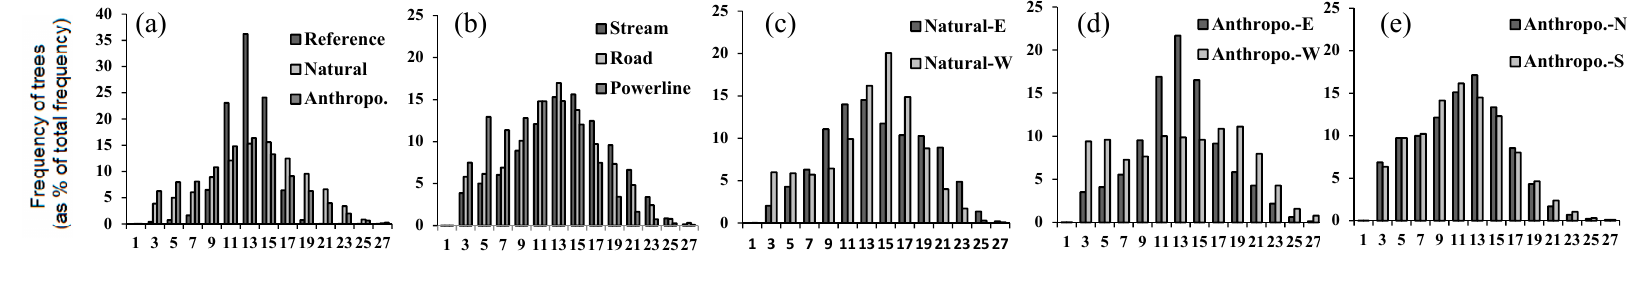
Figure 3. Comparison of the frequency distribution of total height of individual trees in forests surrounding different linear openings with that of the undisturbed reference forest. Height distributions ( a ) for natural vs. anthropogenic openings, ( b ) between types of linear openings, ( c ) on both sides of natural linear openings oriented N-S, ( d ) on both sides of anthropogenic linear openings oriented N-S, and ( e ) on both sides of natural linear openings oriented E-W.